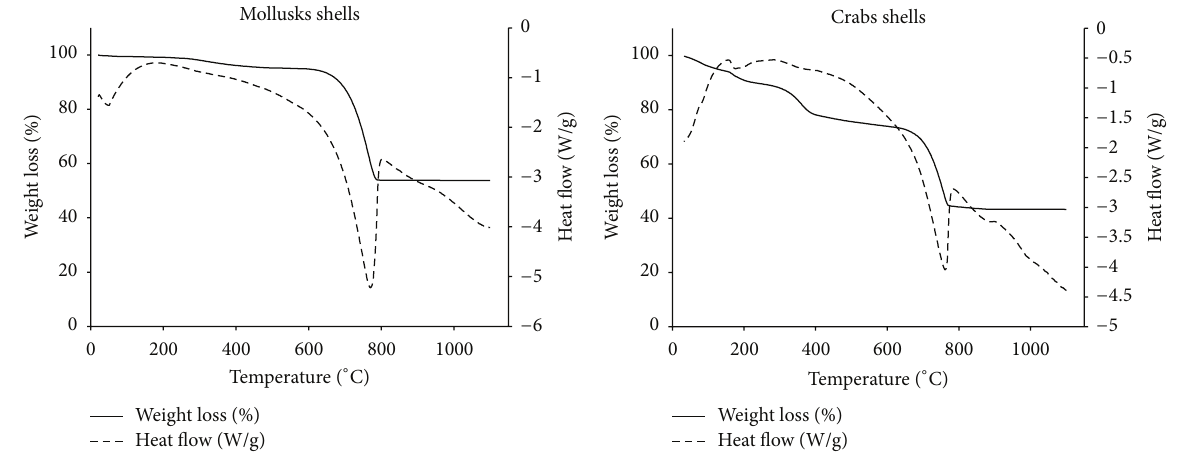
Figure 1: TGA/DSC